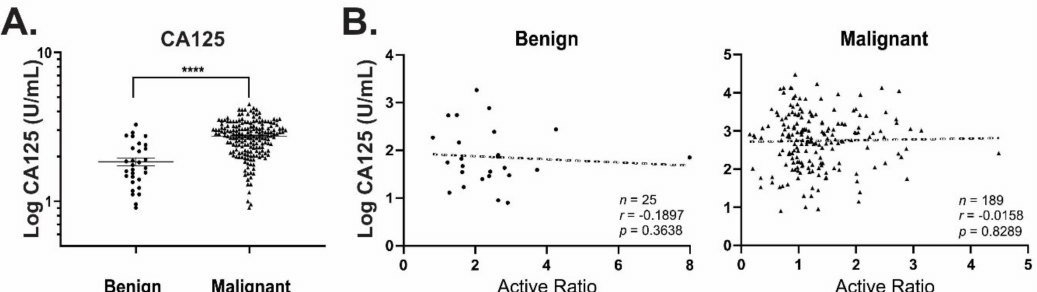
Figure 5. CA125 does not correlate with active ratio. ( A ) Plasma CA125 was measured for patients with either benign (200.8 ± 368.7 U mL − 1 ; n = 48) or malignant ovarian tumours (1697.0 ± 3409.0 U mL − 1 ; n = 188). Mean +/ − SD, **** p ≤ 0.0001. ( B ) No significant correlation was observed between CA125 and active ratio in either